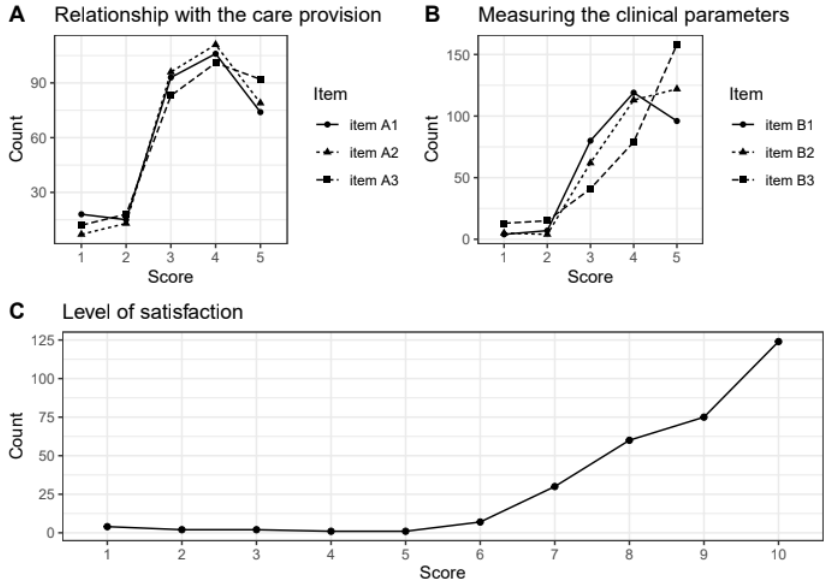
Figure 8. Summary of responses on satisfaction with the service. A high score indicates a positive